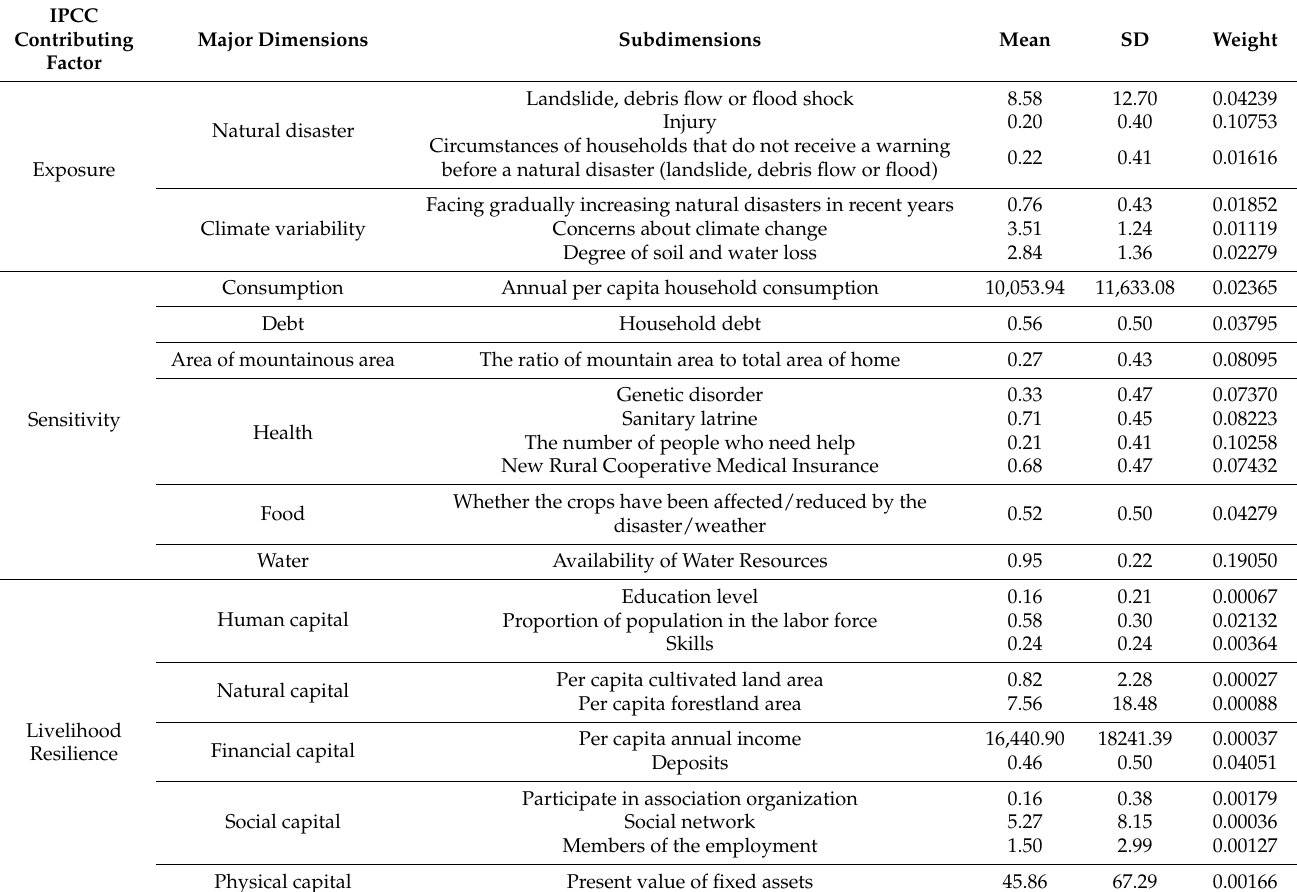
Table 2. Basic statistics and weight of the IPCC-LVI measurement. (Source: the author, 2021). IPCC